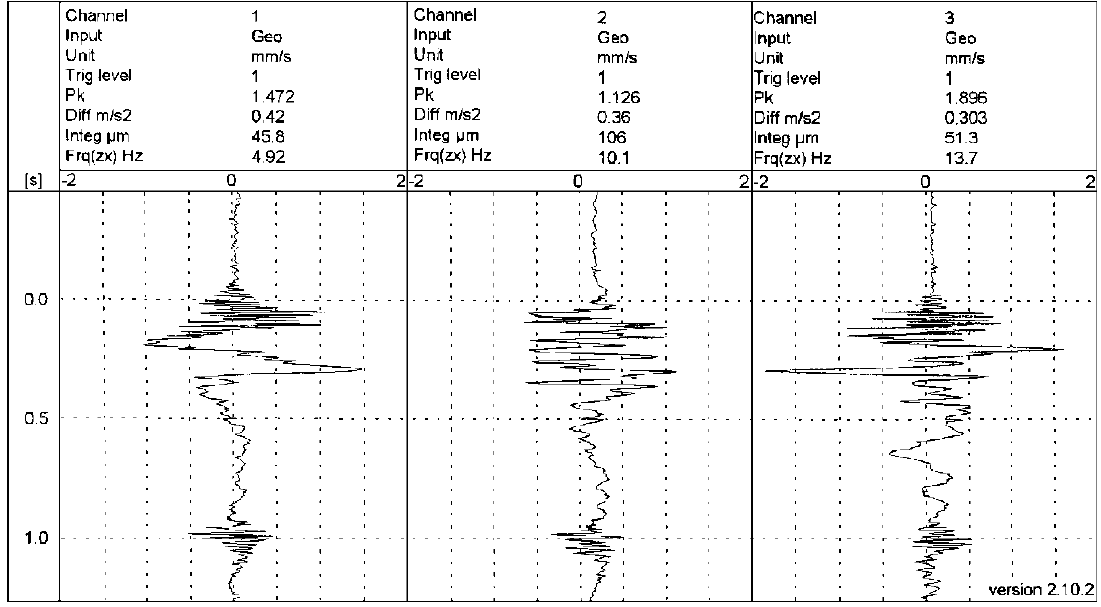
Figure 5. Image of soil oscillation velocity for blasting II ‐ MM3 in the Kovilova č a Open Pit.